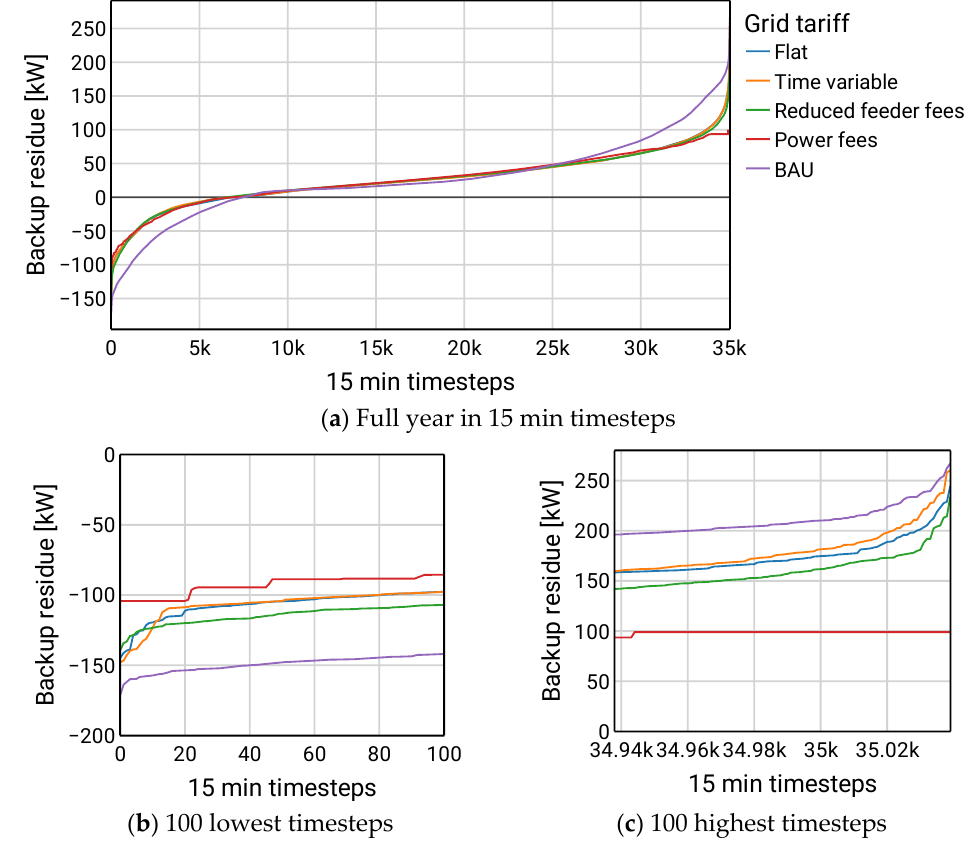
Figure 8. Load duration curves for a variation of grid tariff scenarios for a full simulation year ( a ), the 100 timesteps with lowest residual load ( b ) and the highest residual load ( c ). Data from scenario year 2035 and the rural distribution grid.